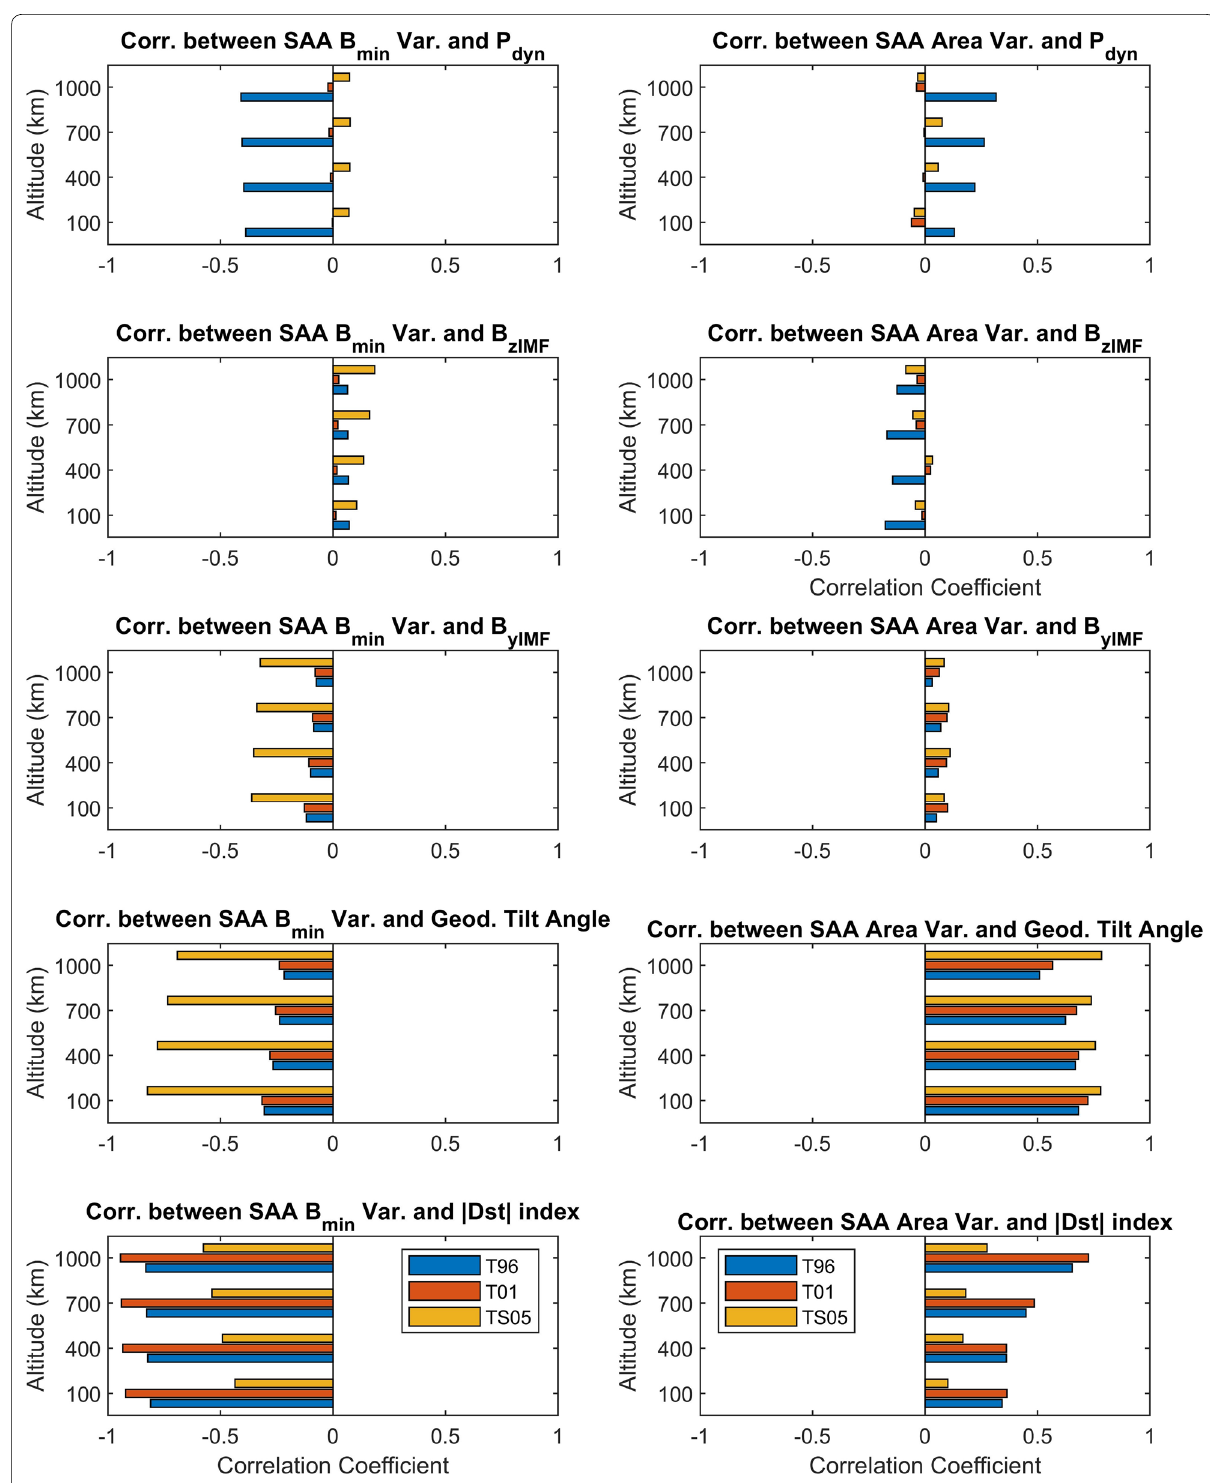
Fig. 5 Statistical study results. The statistical study illustrates the correlation coefficients of the area and the B min of the SAA center according to altitude for the Tsyganenko models, T96, T01 and TS05, referencing the different space weather